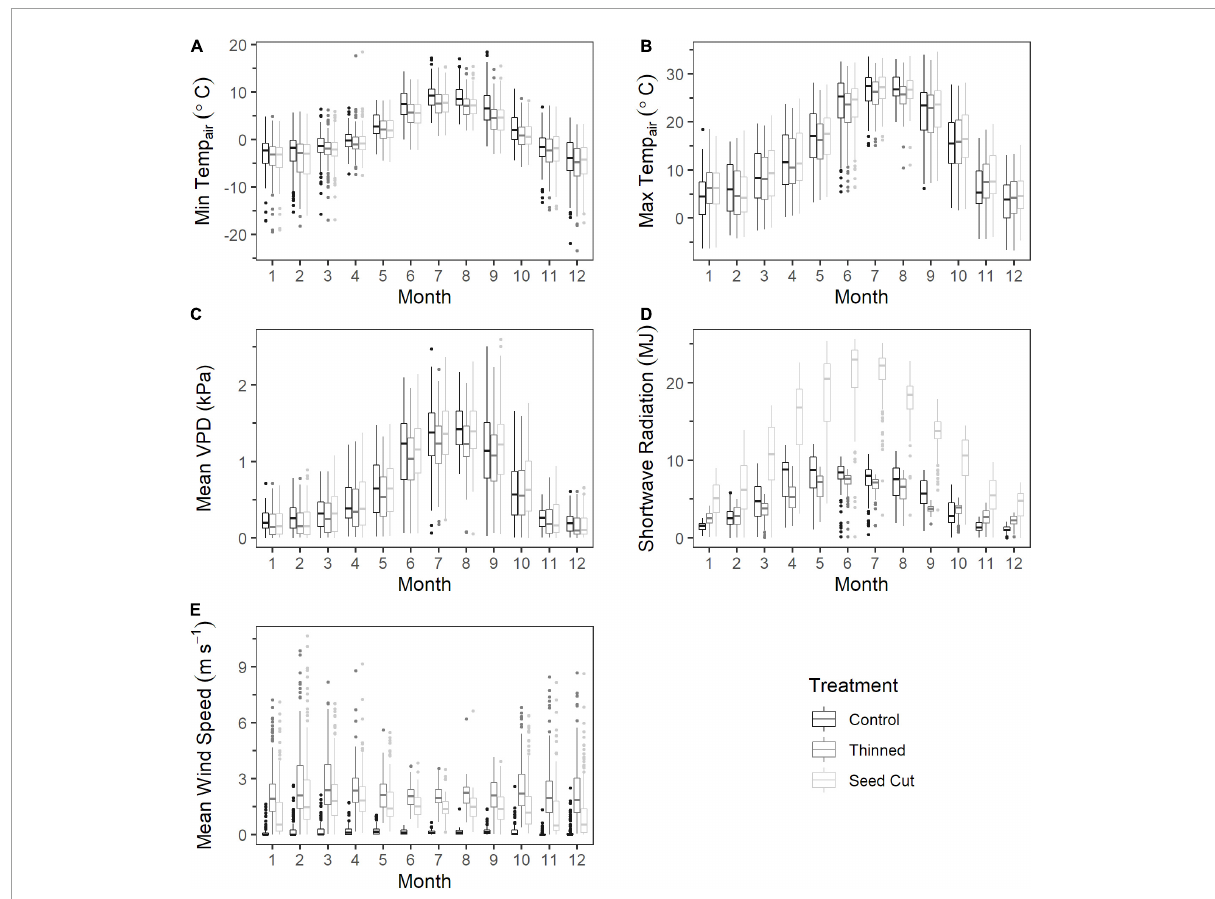
FIGURE4 Meanmonthly micrometeorological data derived from daily (24-h) averages at the three monitoring sites. Note variation in y-axis scales. (A) Nighttime minimum air temperature. (B) Daytime maximum air temperature. (C) Mean vapor pressure deficit (VPD) calculated from paired temperature and relative humidity. (D) Cumulative flux of shortwave radiation. (E) Mean wind speed. Plotted points represent data 1.5 times the interquartile range. Median values are given in Table 3